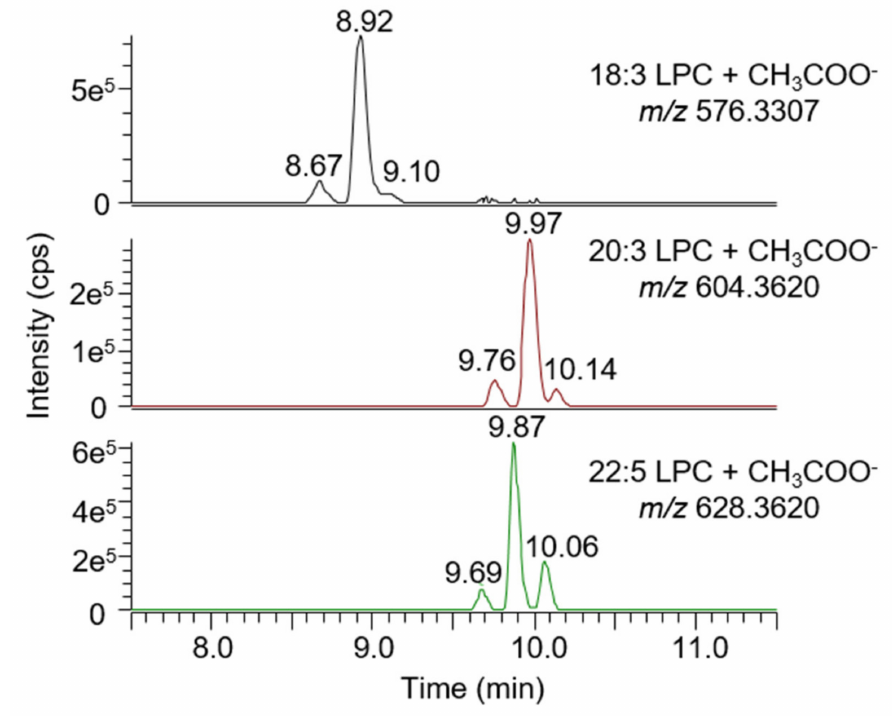
Figure 3. Extracted chromatograms of 18:3 LPC ( top ), 20:3 LPC ( middle ), and 22:5 LPC ( bottom ) in plasma. In all cases, a third signal could be observed in addition to the classical sn-1 / sn-2 pair of